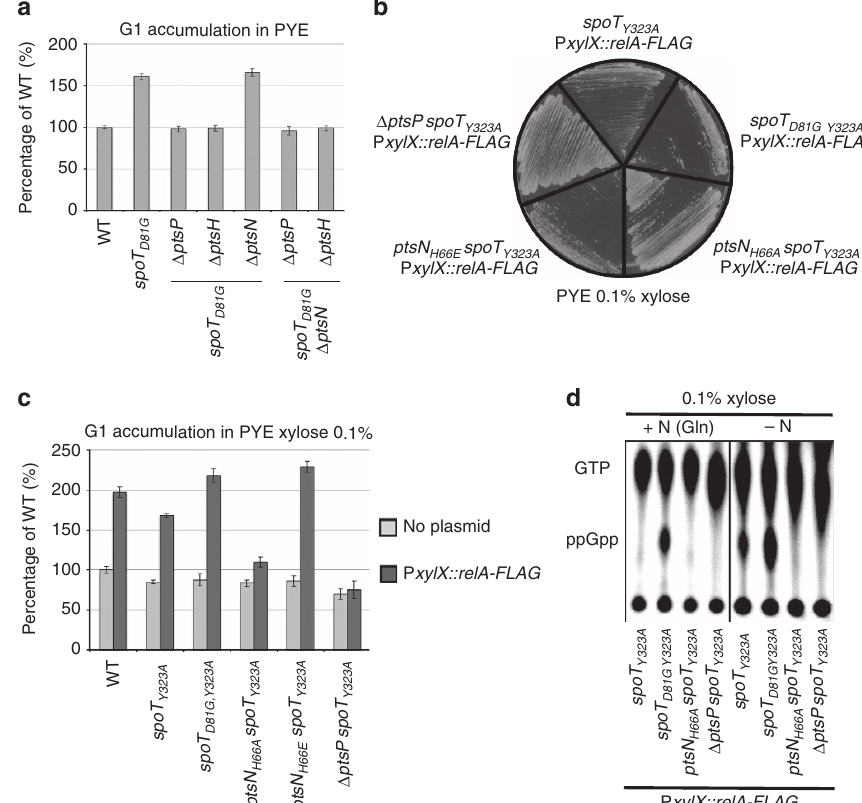
Figure 7 | EIIA Ntr B P inhibits the hydrolase activity of SpoT. ( a ) spoT D81G is insensitive to the absence of EIIA Ntr . G1 proportion was measured in wild-type (WT; RH50), spoT D81G (RH1752), spoT D81G D ptsP (RH1727), spoT D81G D ptsH (RH2013), spoT D81G D ptsN (RH1999), spoT D81G D ptsN D ptsP (RH2014) and spoT D81G D ptsN D ptsH (RH2015) grown in complex media (PYE) and normalized to the WT (100%). Error bars ¼ s.d.; n ¼ 3. ( b ) The hydrolase activity of SpoT is required for growth on an artificial exogenous production of (p)ppGpp. Growth of spoT Y323A , spoT D81G Y323A , ptsN H66A spoT Y323A , ptsN H66E spoT Y323A and D ptsP spoT Y323A expressing a truncated version of E. coli relA from the inducible xylX promoter (P xylX::relA-FLAG ) on PYE medium supplemented with 0.1% of xylose. ( c ) Reduction of SpoT hydrolase activity led to a G1 extension on an artificial exogenous production of (p)ppGpp. Flow cytometry analysis to determine DNA content in asynchronous population of WT, spoT Y323A , spoT D81G Y323A , ptsN H66A spoT Y323A , ptsN H66E spoT Y323A and D ptsP spoT Y323A with (dark grey bars) or without (light grey bars) P xylX::relA-FLAG in PYE medium supplemented with 0.1% of xylose. The data were normalized to the WT without P xylX::relA-FLAG (100%). Error bars ¼ s.d.; n ¼ 3. ( d ) The hydrolase activity of SpoT is required to degrade (p)ppGpp in þ N condition. Intracellular levels of (p)ppGpp detected by TLC after nucleotides extraction of spoT Y323A , spoT D81G Y323A , ptsN H66A spoT Y323A and D ptsP spoT Y323A containing P xylX::relA-FLAG in þ N or (cid:2) N medium supplemented with 0.1%